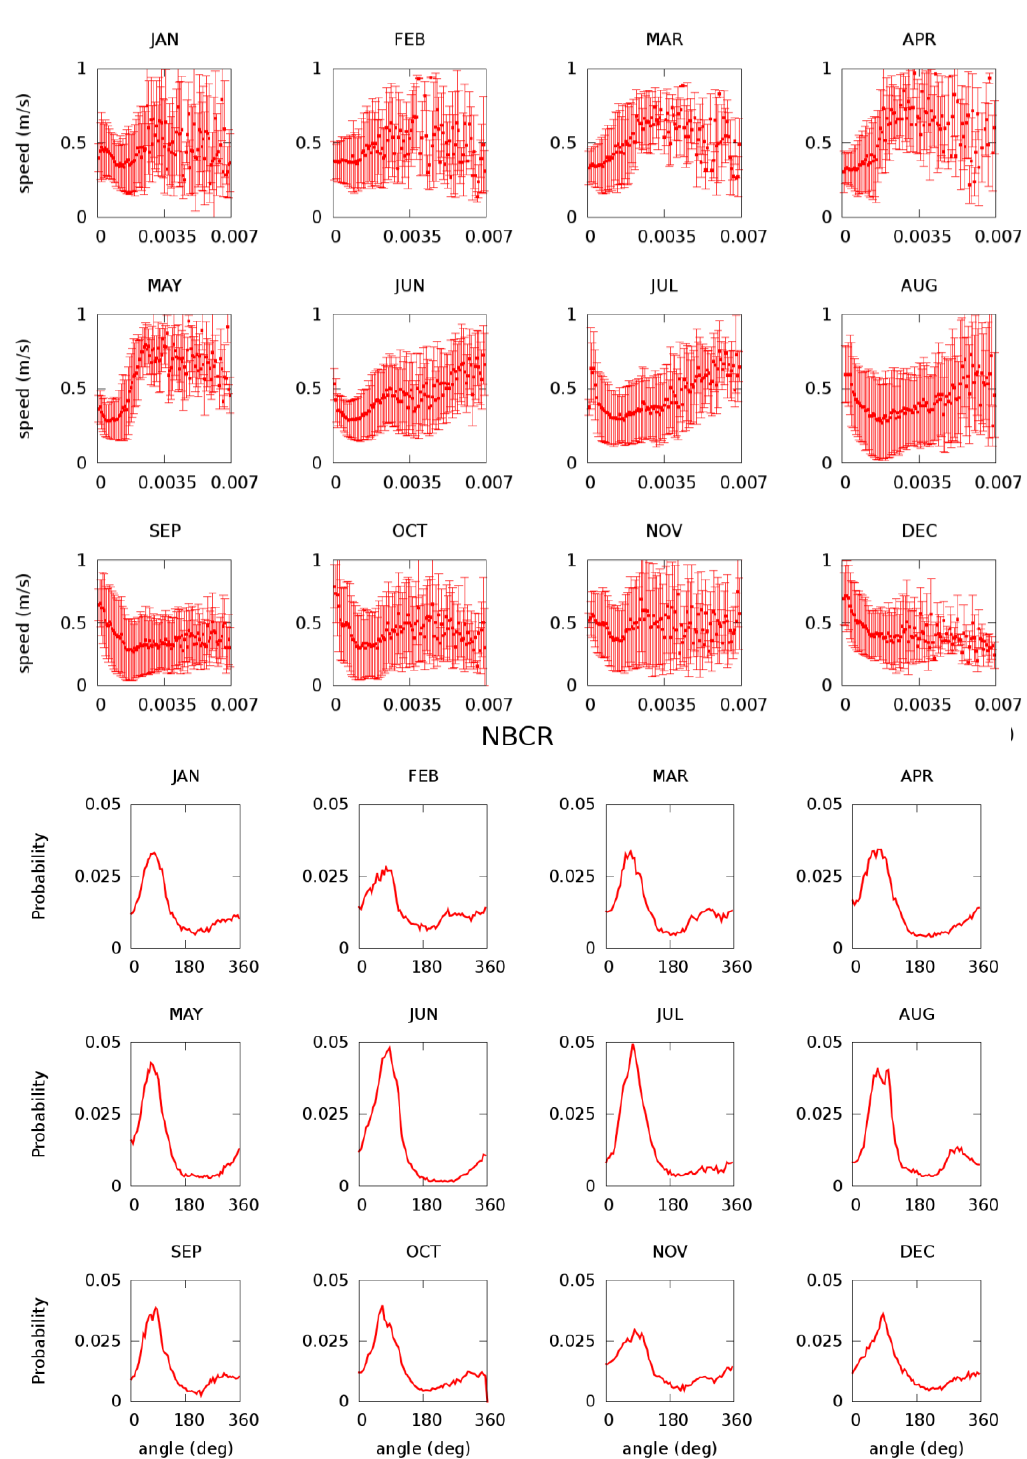
Figure 5. Monthly dependence of the horizontal speed of water and the SSS horizontal gradient in the NBCR, as inferred from HYCOM. ( Top panels ) Maximum probability value and standard deviations for water speed as a function of the absolute value of the SSS gradient. ( Bottom panels ) Frequency distribution of the angle between SSS gradient and surface water velocity vectors (measured from the former to the latter).